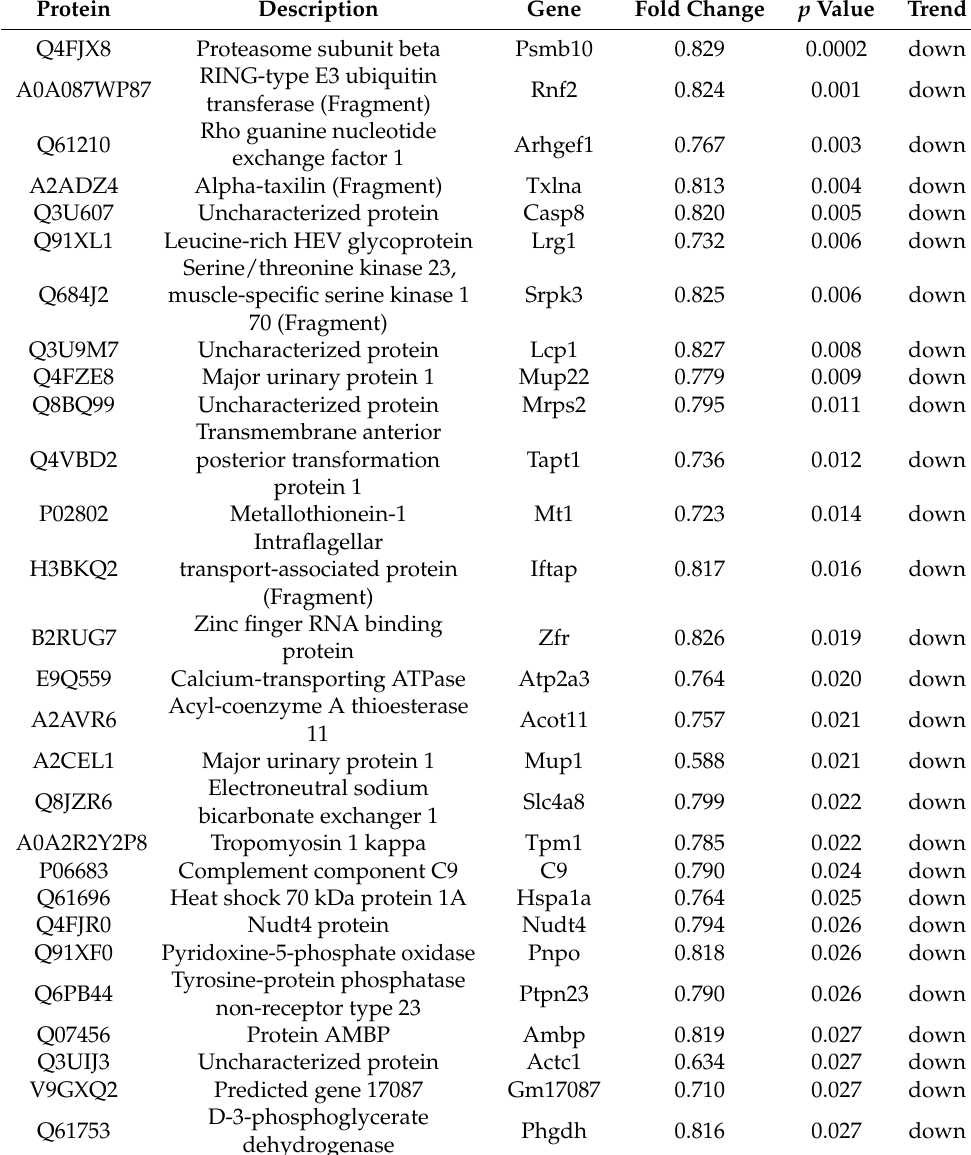
Table 3. The down-trend DEPs between the ACM group and the control